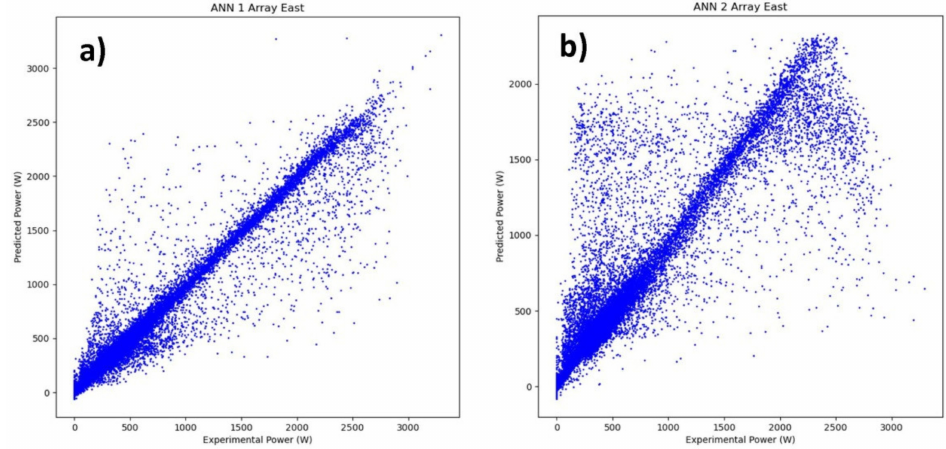
Figure 9. Scatter plot of the power modeled with ANN for the East 1 array including FS as input ( a ) compared to the case of no FS in the input variables ( b